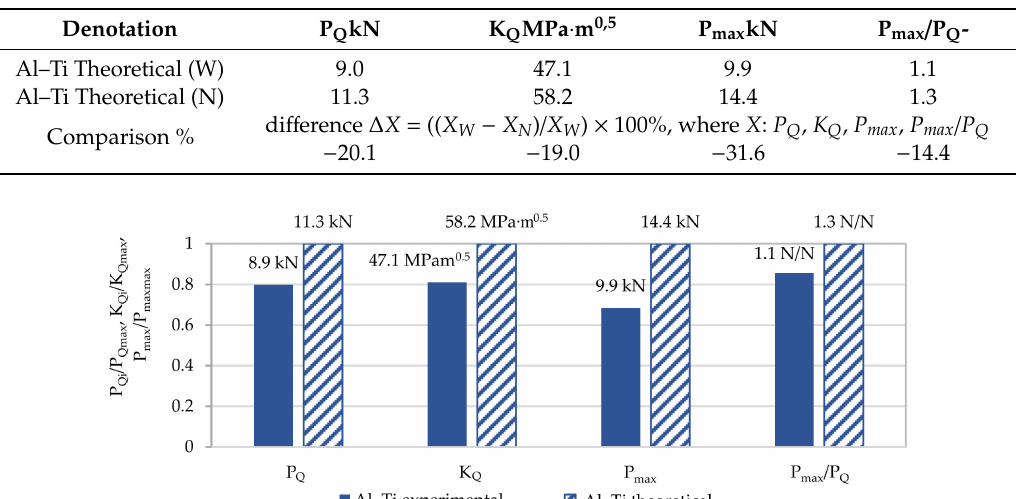
Table 7. Comparison of selected mechanical properties obtained experimentally and through calculations for the layered Al–Ti material determined in ambient conditions.